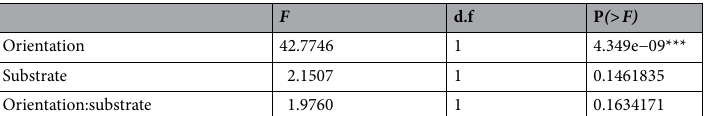
Table 1. Mixed model examining the effect of swimming orientation and substrate type on the white-squid location at the end of color-changing event, as a response variable. Swimming orientation type (arm-leading, mantle-leading) and substrate type (light, dark) were modelled as fixed effects. Inter-individual variation was modelled as a random effect. Asterisks indicate statistical